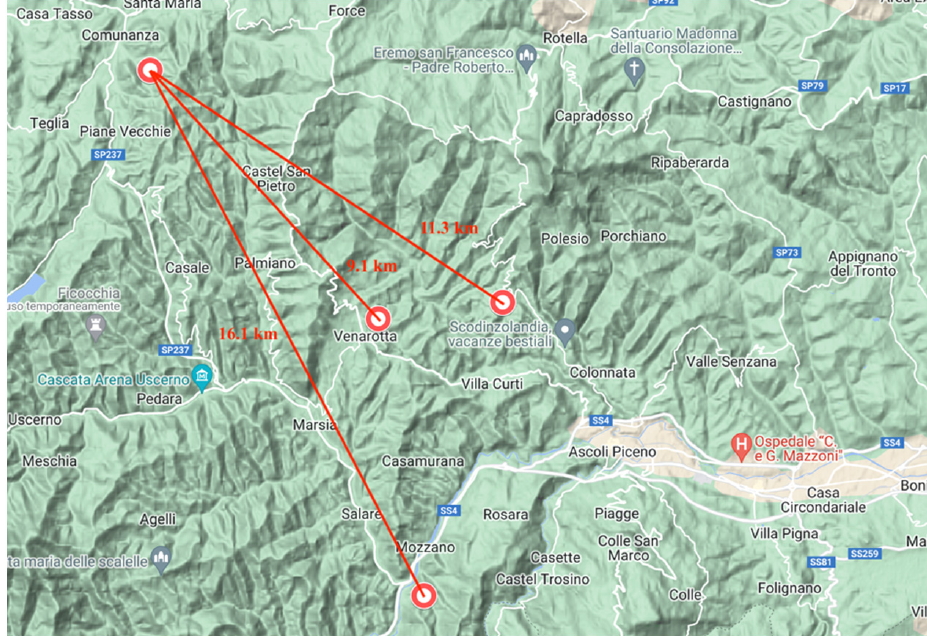
Figure 1. Positive animal samples: hunting localization. Red circles identify where animals were hunted.